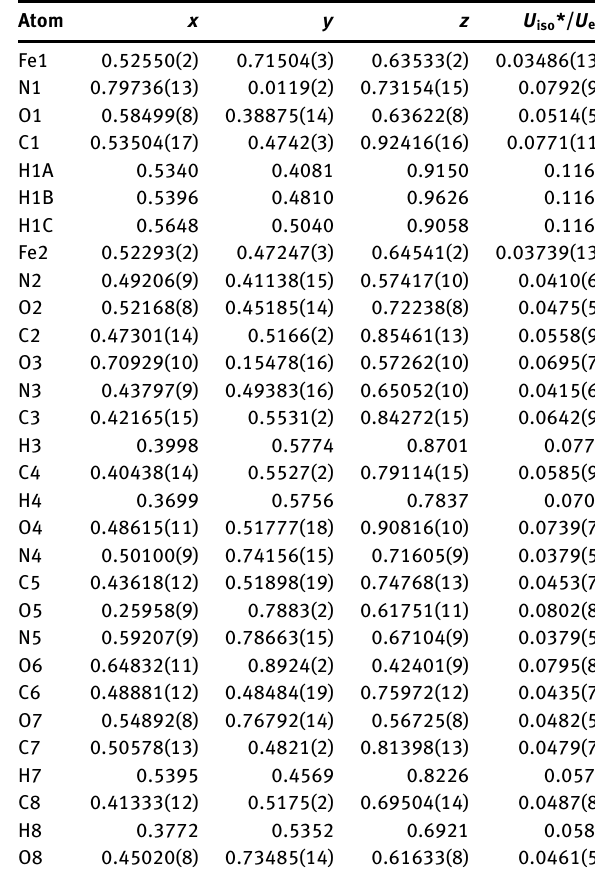
Table 2: Fractional atomic coordinates and isotropic or equivalent isotropic displacement parameters (Å 2